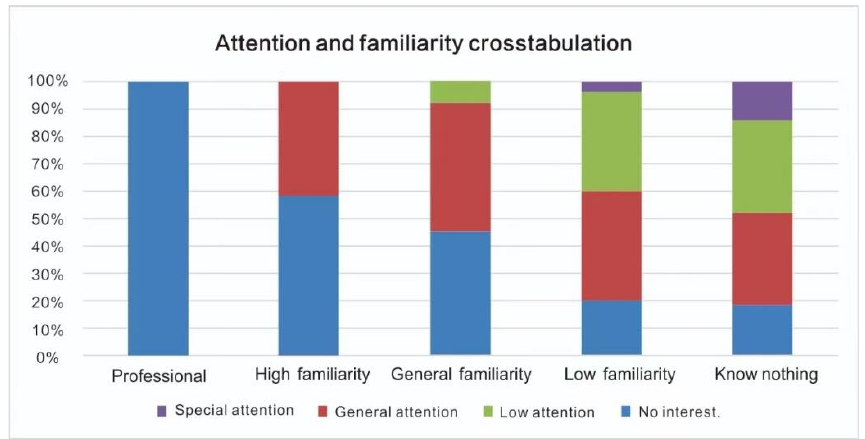
Figure 3. Attention and familiarity crosstabulation.